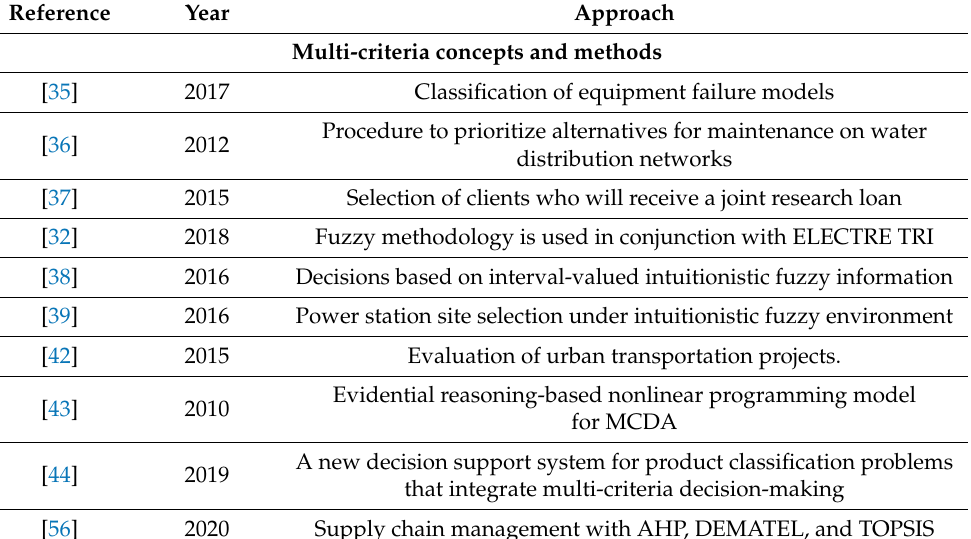
Table 1. Summarized theoretical